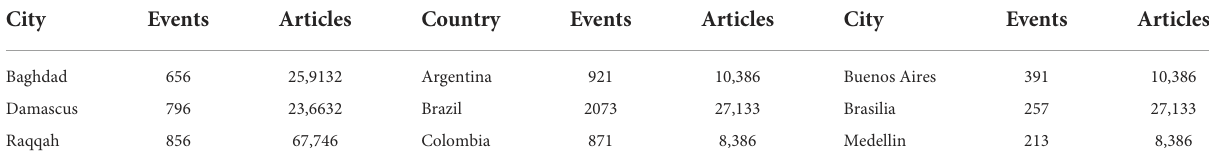
TABLE 1 Datasets of MANSA events and LA